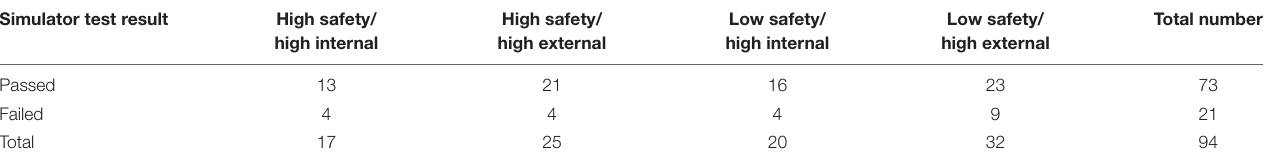
TABLE 6 | Numbers of participants for the four ratings categories according to driving simulator test results. Simulator test